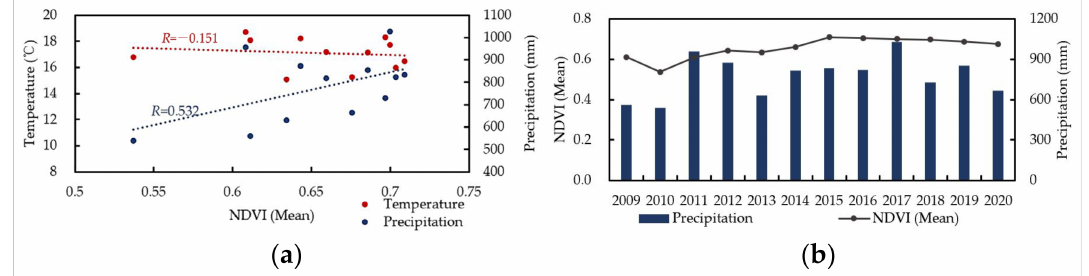
Figure 12. NDVI versus temperature and precipitation for 2009 to 2020. ( a ) Correlation of NDVI with temperature and precipitation; ( b ) Precipitation vs. NDVI.